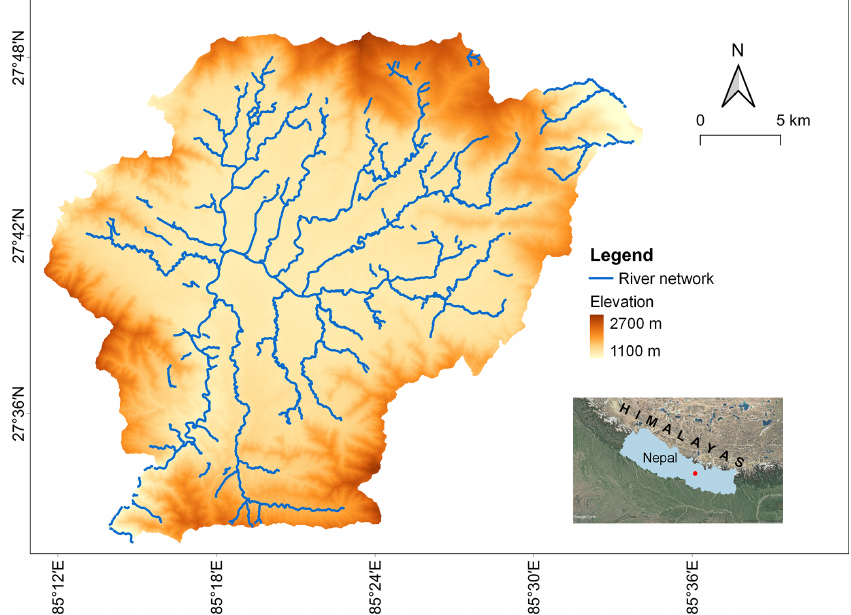
Figure 1. Physical map of Kathmandu Valley. The river network is taken directly from © OpenStreetMap (OSM) contributors 2022. Dis- tributed under the Open Data Commons Open Database License (ODbL) v1.0. Small streams appear cut off where OSM data are incomplete. Inset map data: © Google Earth.